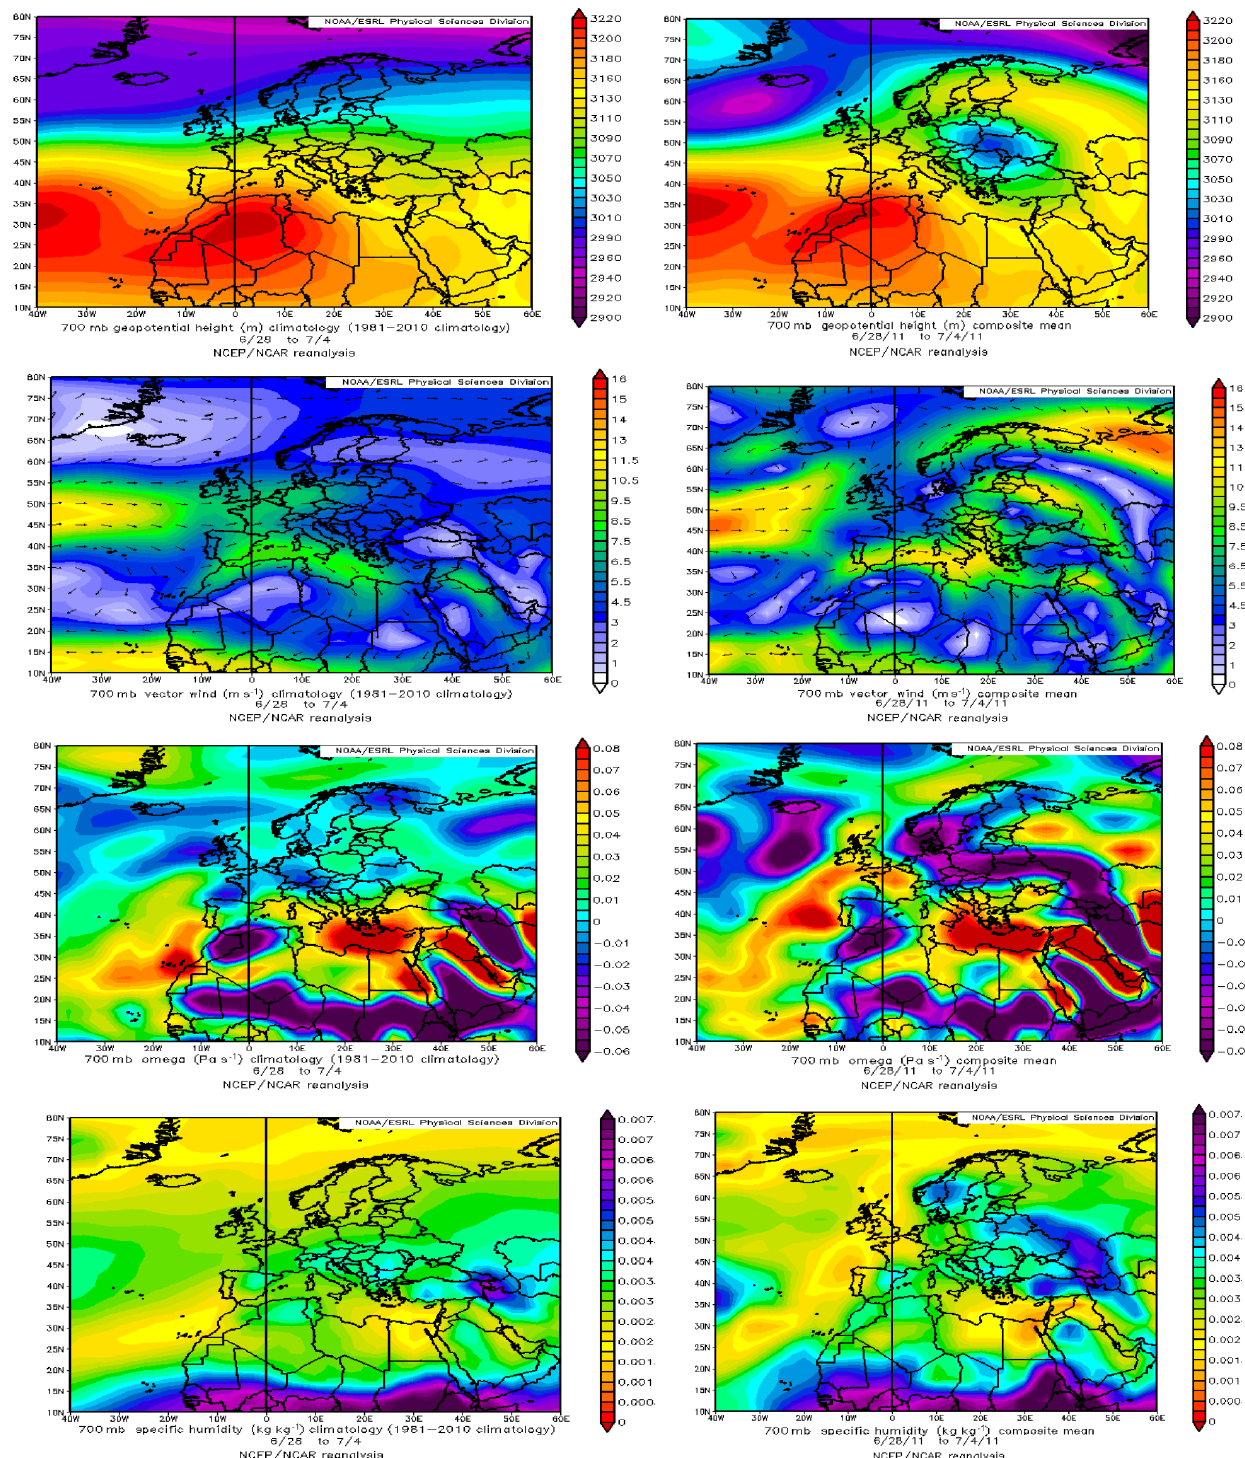
Figure 7. Composite NOAA/ESRL weather maps of geopotential height, vector wind speed, omega vertical velocity and specific humidity for 28 June–4 July 2011 climatology (left column) and for the episode of 28 June-4 July 2011 at JRC Ispra, Italy (right